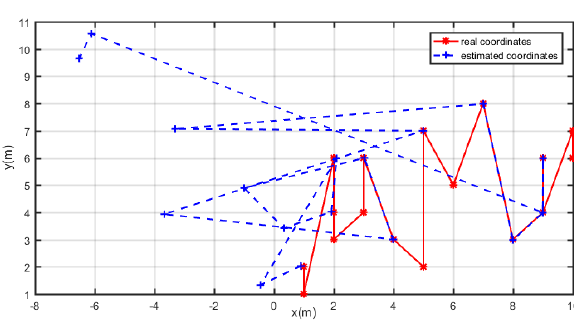
Fig. 5. Localization of 20 points using initialization 4.